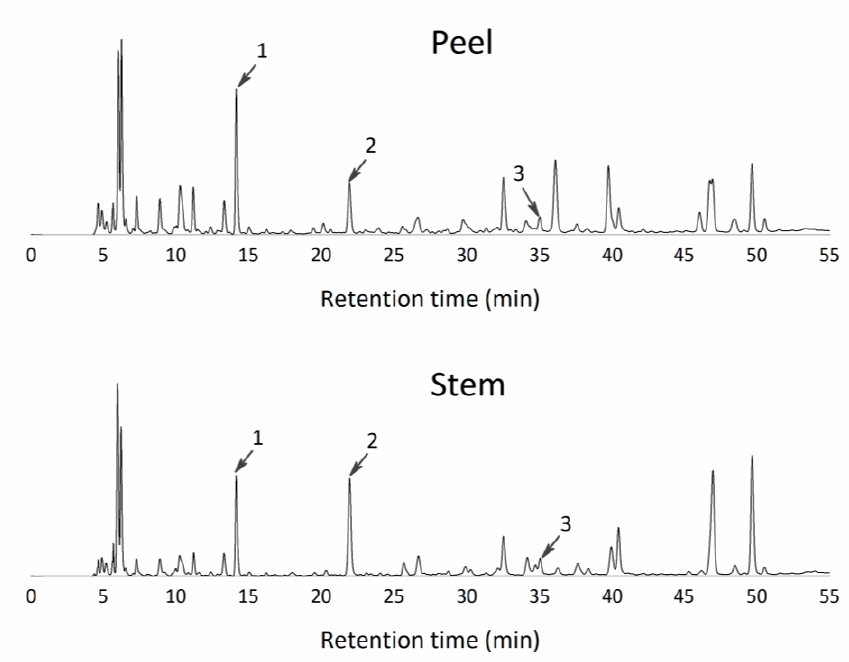
Figure 4. Chromatograms of the main peaks found and identified as free phenolic compounds of pineapple by-products at a wavelength of 280 nm. The liquid fraction of peels and the liquid fraction of stems. 1 — Gallic acid; 2 — Hydroxytyrosol; 3 — 2,5-dihydroxybenzoic.